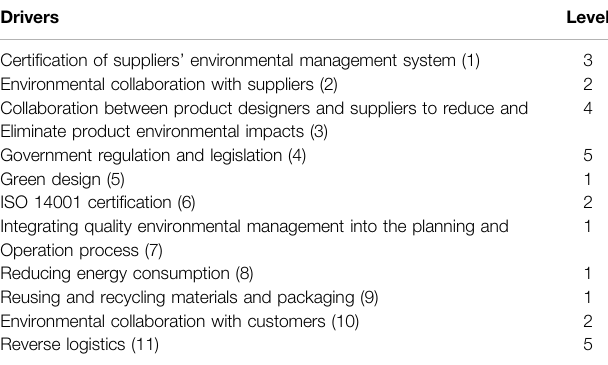
TABLE 1 | Hierarchy of the drivers affecting the implementation of green SCM (Diabat and Govindan, 2011).